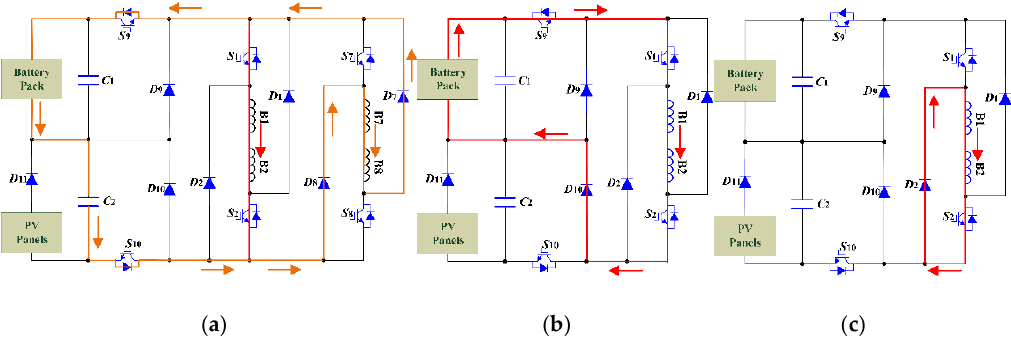
Figure 4. When ϴ on < ϴ < ϴ off , the excitation process of the SRM system is powered by the battery pack. ( a ) Stage 1. ( b ) Stage 2. ( c ) Stage 3. ( a ) Stage 1. ( b ) Stage 2. ( c ) Stage